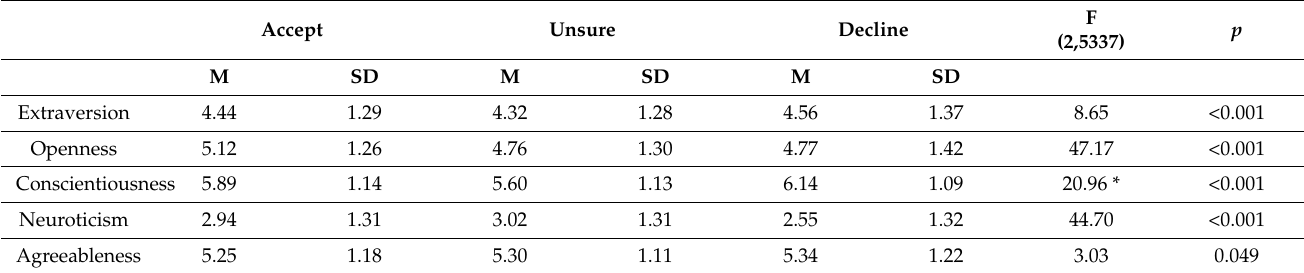
Table 2. Relationship between Big Five personality traits and likelihood of accepting COVID-19